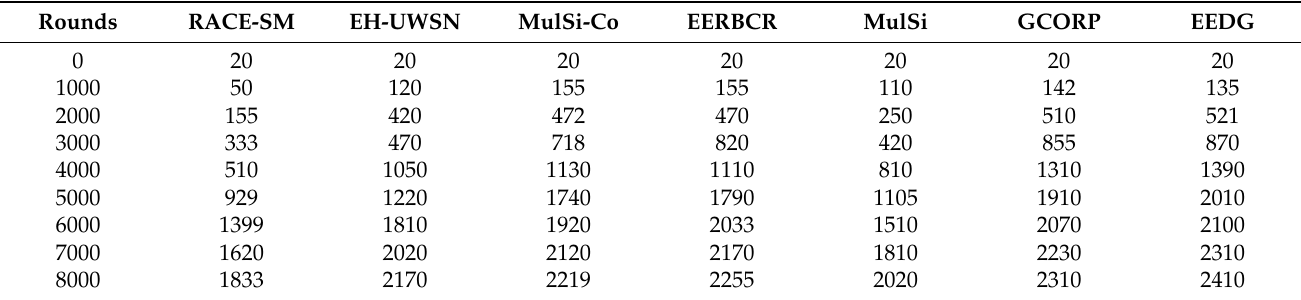
Figure 2. Energy consumption. Table 2. The energy consumption of all routing protocols.